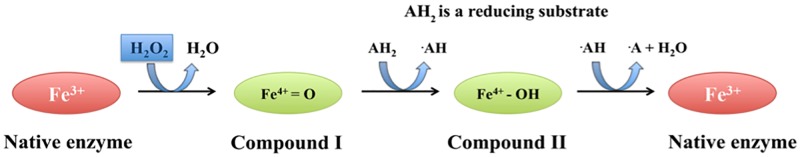
The reaction mechanism of plant peroxidases.